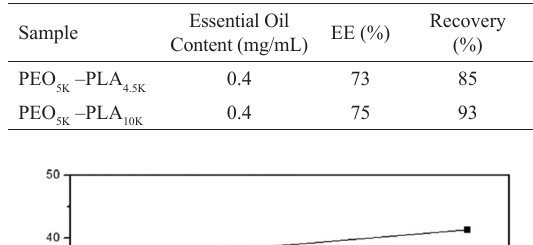
Figure 6: Size distributions obtained from NTA measurements with the corresponding captured images from NTA video and 3D graph size vs. intensity vs. concentration obtained for: (A) PEO PLA filtered through a 0.45 μm membrane; and (B) PEO 4.5KDa b -PLA containing 10% lavender essential oil filtered through 4.5KDa a 0.45 μm membrane. The NTA videos obtained are available as supplementary data. Table 3: Entrapment efficiency and essential oil quantification of the nanoparticle suspensions.